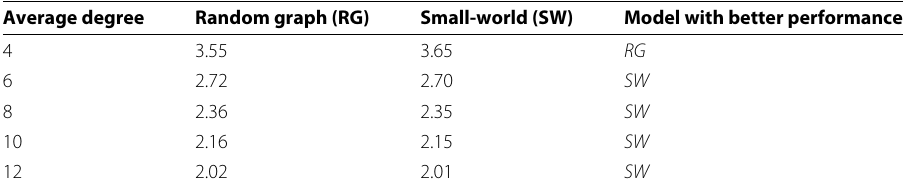
Table 5 Performance comparison of Average Delivery Path Length between the small-world and the random graph Average degree Random graph